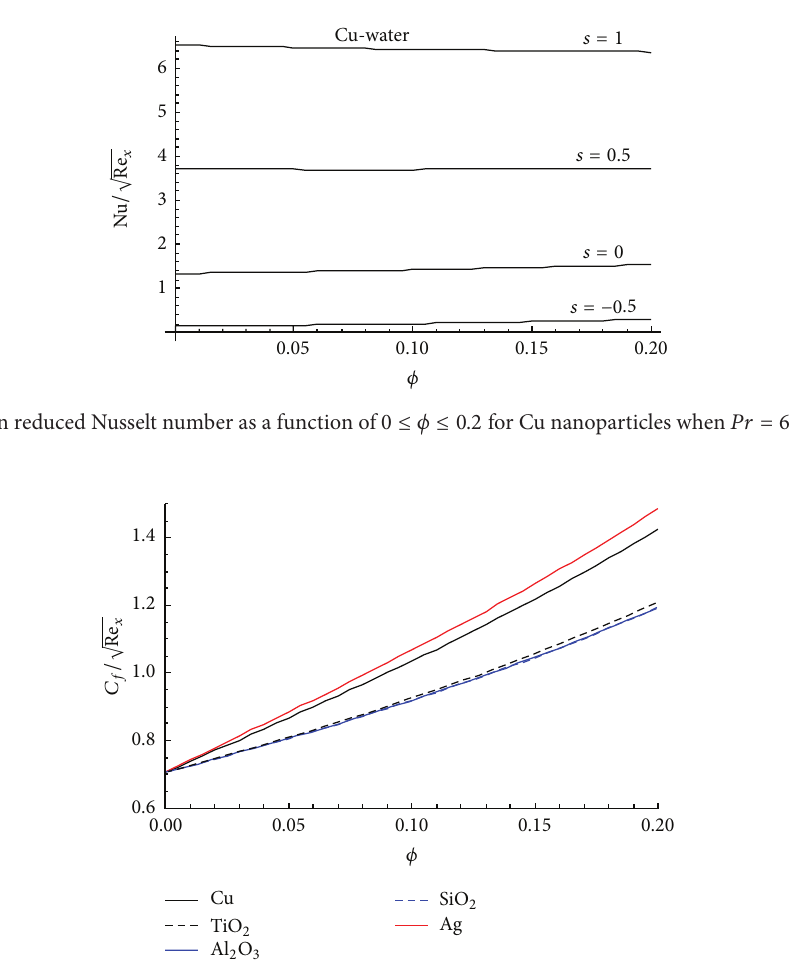
Figure12:Comparingthevariationofreducedskinfrictioncoefficientasafunctionof 0 ≤ 𝜙 ≤ 0.2 fortheinvestigatednanoparticles 𝑃𝑟 = 6.2 , = 0.5 , 𝛿 = 0 , and 𝑠 = 0.5 . 𝛿 1 2